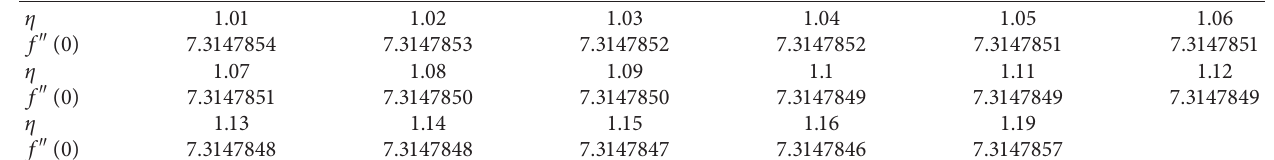
� 1 (error � 1 E − 7). 0